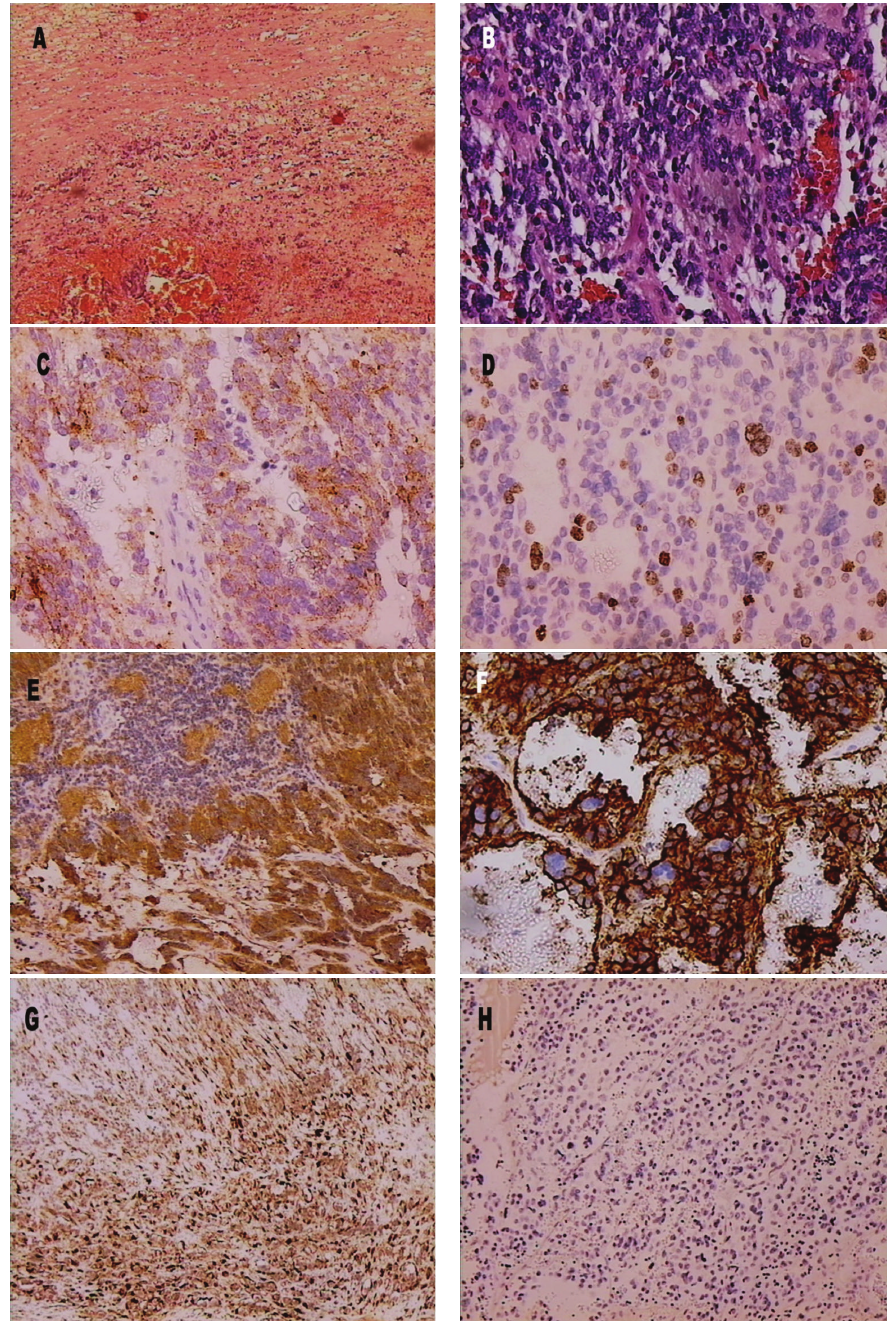
Figure 2: Immunohistochemical staining of the tumor cells. (A) H&E staining, × 25 magnification, (B) H&E staining, × 200 magnification (C) positive chromogranin staining, × 200 magnification, (D) positive synaptophysin staining × 200 magnification, (E) positive NSE staining, × 100 magnification, (F) positive CD56 staining, × 200 magnification, (G) positive S-100 staining, × 50 magnification, and (H) negative PanCK staining, × 100